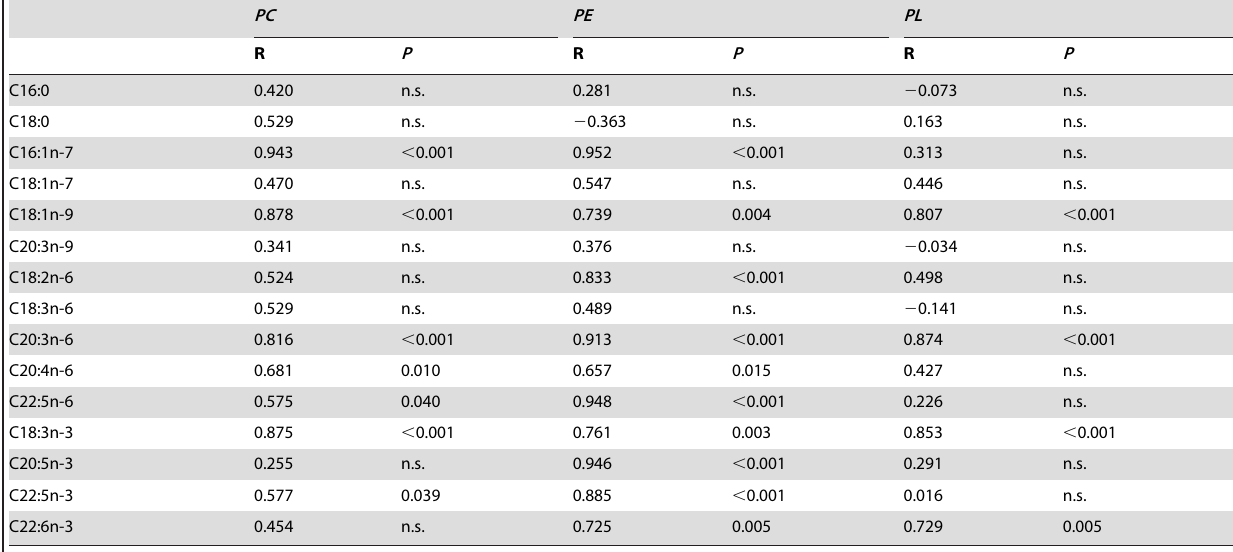
Correlation of individual GPL fatty acids